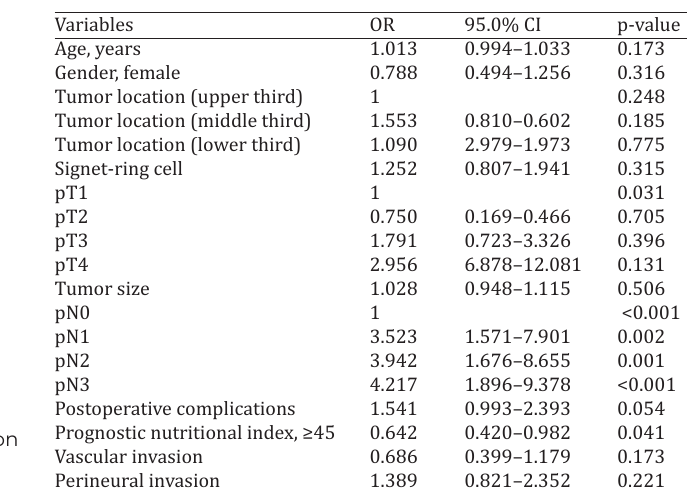
Evaluation of the effect of prognostic factors on overall survival based on a multivariate Cox regression analysis